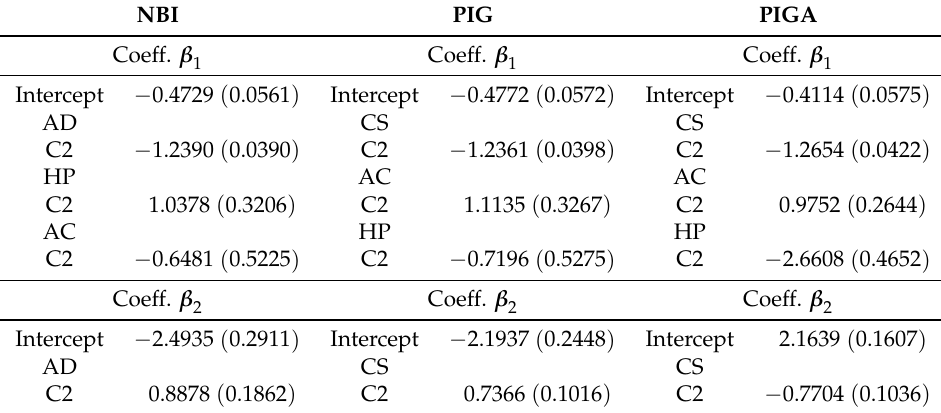
Table 3. NBI, PIG, and PIGA regression models with varying